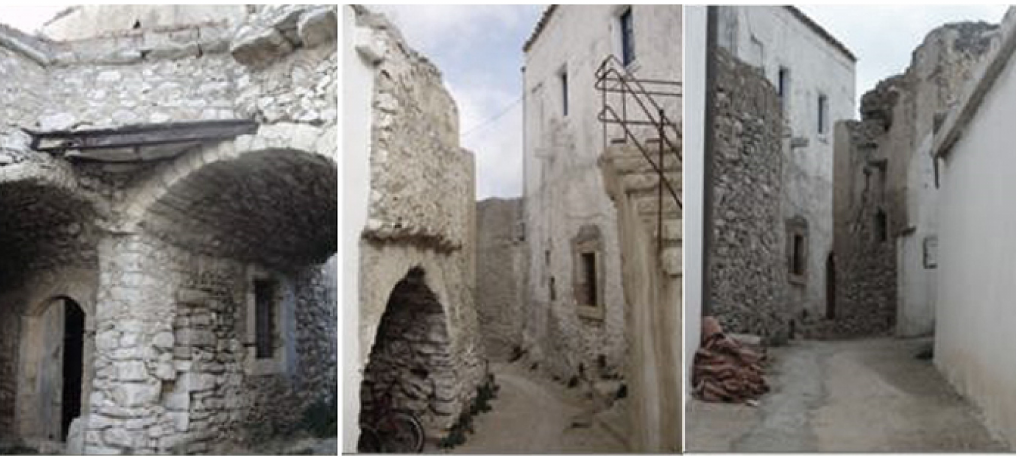
Figure 22. Kastritsianika in Kythera.